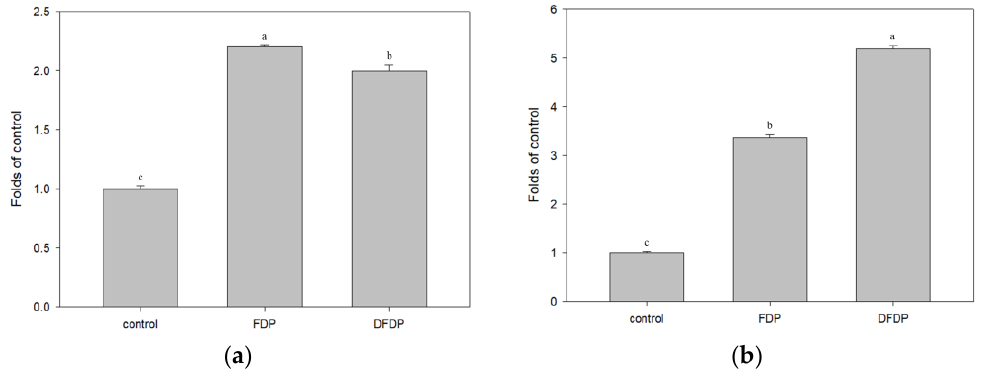
Figure 3. The expression of glucose transporters in hepatocyte cells FL83B post-addition of ethanol extracts from fermented dairy products and Taiwan djulis fermented dairy products ( a ) in the presence of 5 µg/mL insulin and ( b ) in an insulin-free environment. The experiments were performed in triplicate and expressed as mean ± SD. Different letters indicate significant differences from each other.